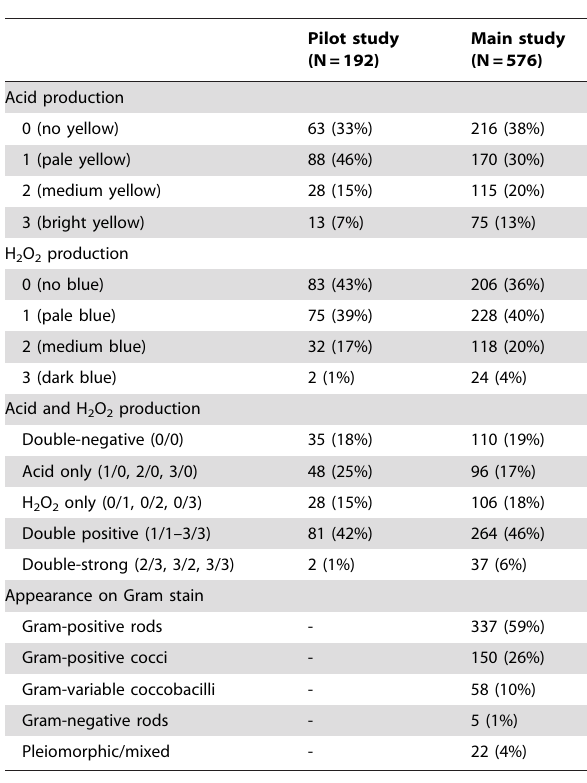
Table 1. Phenotypic characteristics of